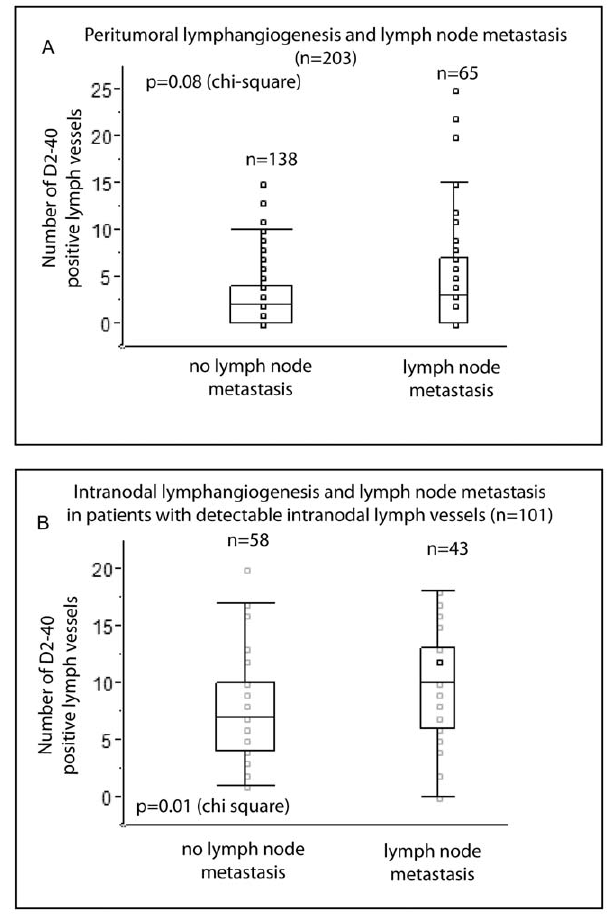
Figure 5. Lymphangiogenesis and metastasis. A. Box plots comparing the number of lymph vessels in the peritumoral region with the presence or absence of lymph node metastasis. B. Box plots comparing the number of regional lymph node lymph vessels in relation with the presence or absence of lymph node metastasis in patients with detectable lymph vessels in the regional lymph